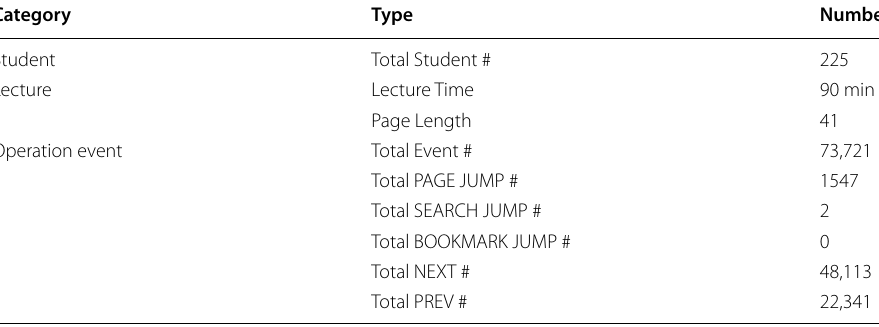
Table 1 Description of the event stream dataset for one of the lectures Category Type Student